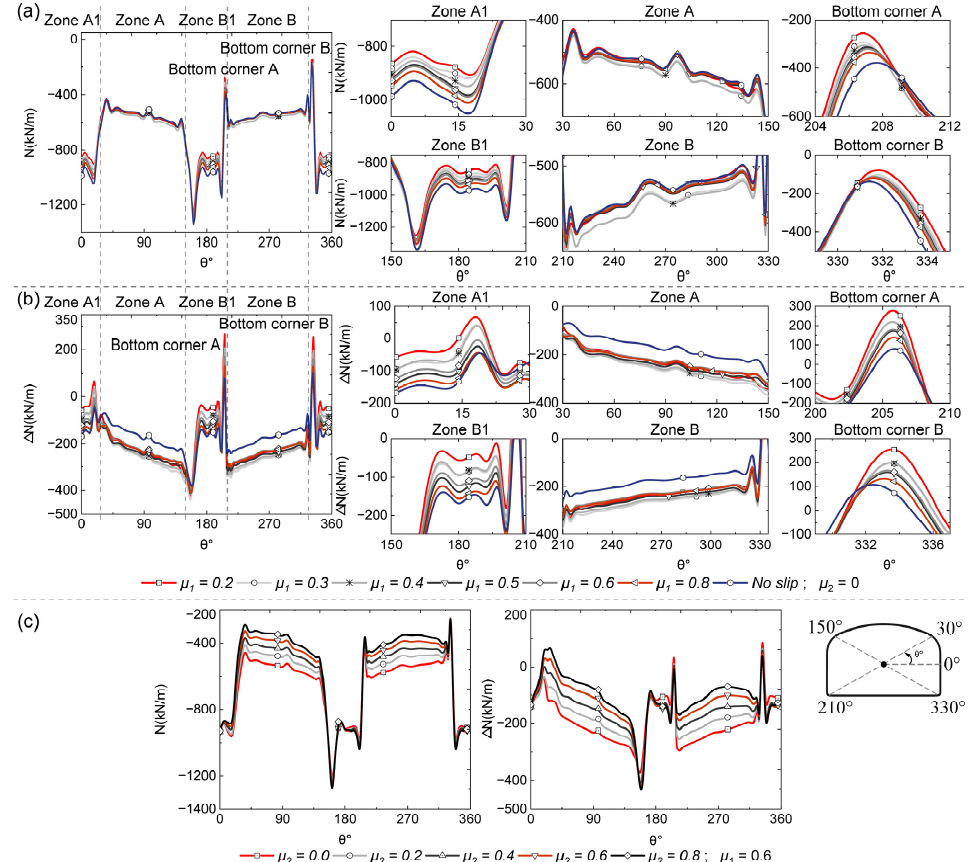
Figure 21. Effect of interface characteristics on axial force ( a ) tunnels without and with primary lin- ing ( b ) tunnels with primary lining; μ 1 = 0.2, 0.4, 0.6, 0.8 and no-slip; μ 2 = 0 ( c ) tunnels with primary lining; μ 1 = 0.6; μ 2 = 0.2, 0.4, 0.6, 0.8. ( b ) tunnels with primary lining; µ 1 = 0.2, 0.4, 0.6, 0.8 and no-slip; µ 2 = 0 ( c ) tunnels with primary lining; µ 1 = 0.6; µ 2 = 0.2, 0.4, 0.6,